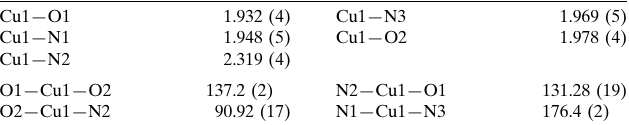
Selected geometric parameters (A˚ , (cid:2)